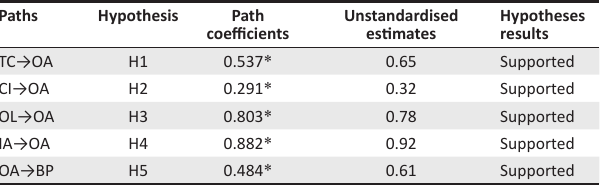
TABLE 5: Structural equation modelling testing of hypotheses Paths Hypothesis Path coefficients